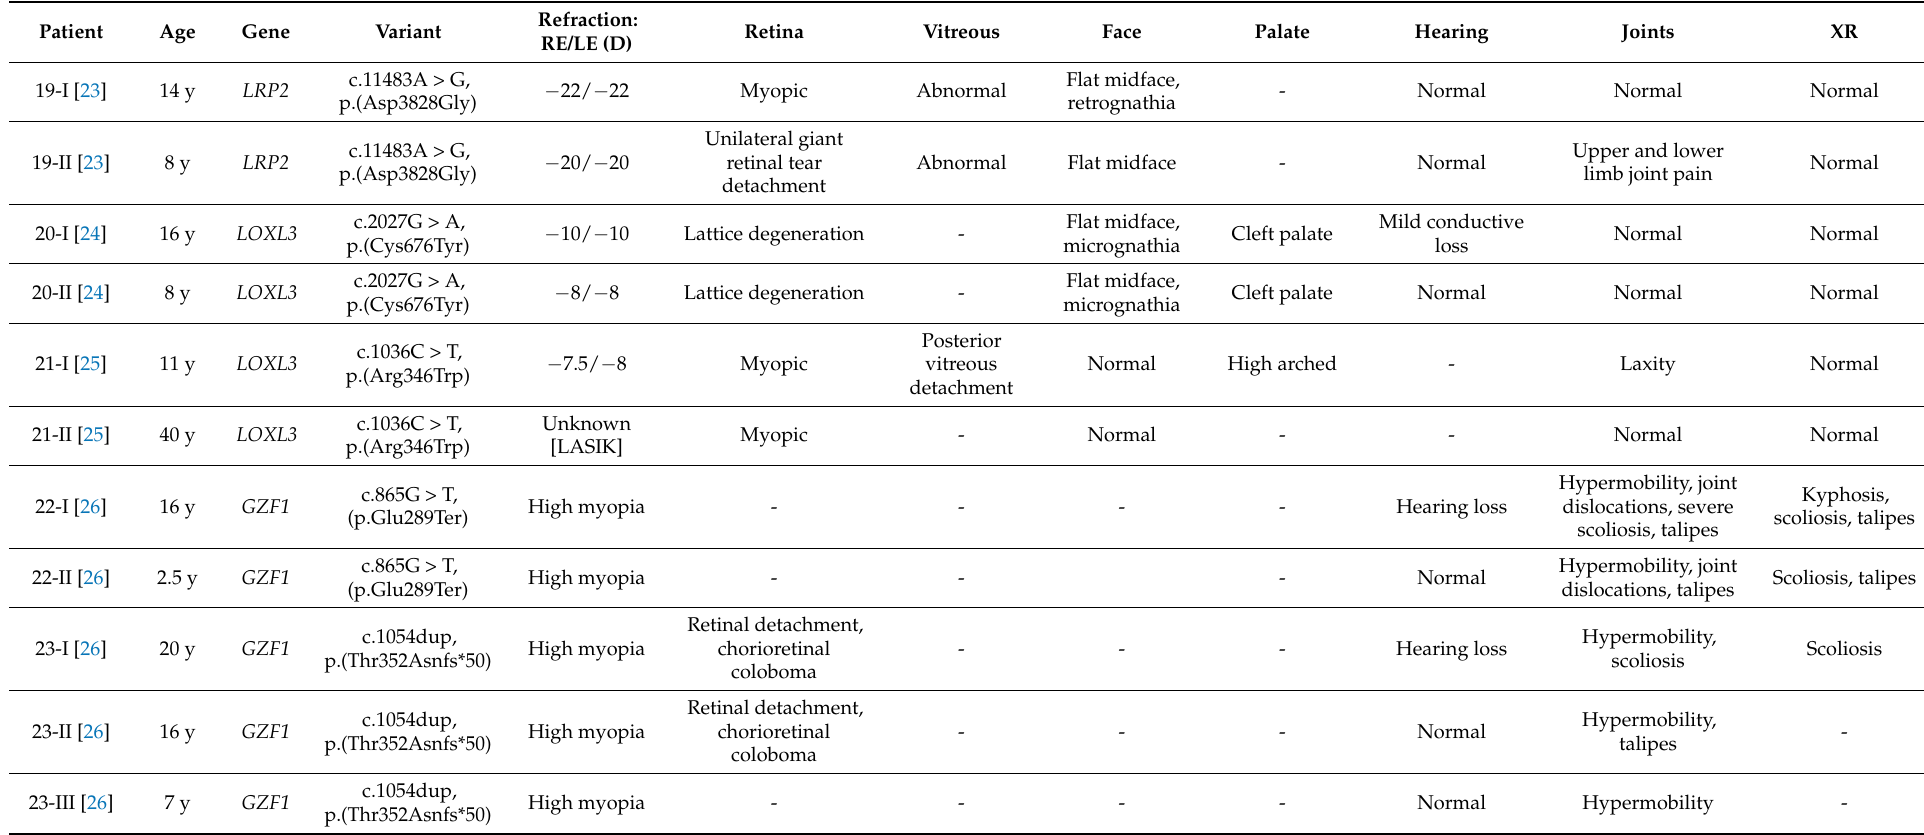
Table 5. Clinical features of patients with pathogenic variants in LRP2 and LOXL3. All variants mentioned are homozygous in the affected